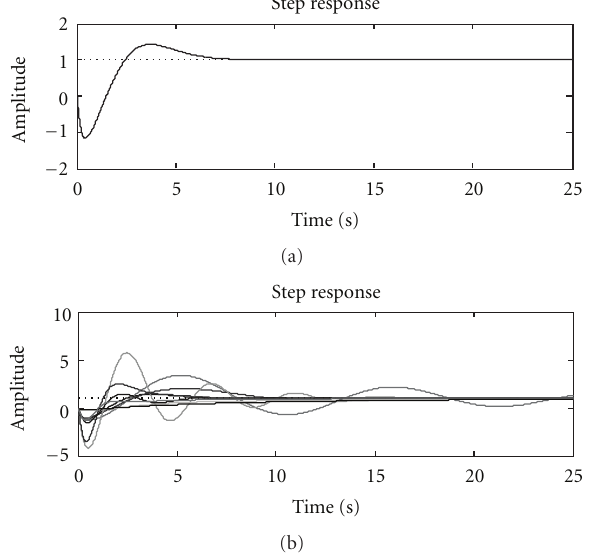
Figure 7: Kharitonov’s templates with ε 1 = 3 . 3 with additive